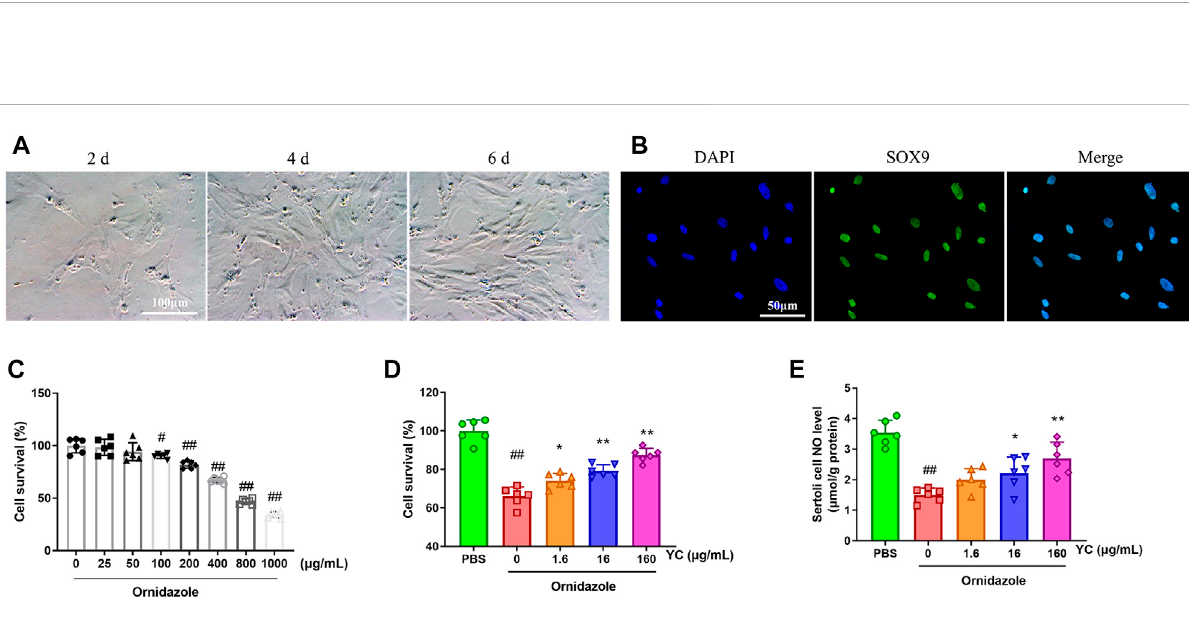
FIGURE 5 Effects of YC on ornidazole-induced oligoasthenozoospermia in primary Sertoli cells. (A) Cell morphology of primary Sertoli cells on different days after isolation. (B) Representative immunostaining staining of SOX9 positive (primary Sertoli cells) counterstained with DAPI. The purity of primary Sertoli cells was > 98%. (C) Primary Sertoli cells were stimulated with ornidazole for 24 h, and viability was assessed by the MTT assay. (D) Primary Sertoli cells weretreatedwithYCextractfor24 h,followedby400 μ g/mLornidazoleforanother24 h.CellviabilitywasassessedbytheMTTassay. (E) NOlevels in Sertoli cells were detected using the corresponding commercial kit. Values are shown as averages ± SD ( n = 6). # p < 0.05, ## p < 0.01 versus the blank or PBS group; * p < 0.05, ** p < 0.01 versus the Ornidazole + YC (0)